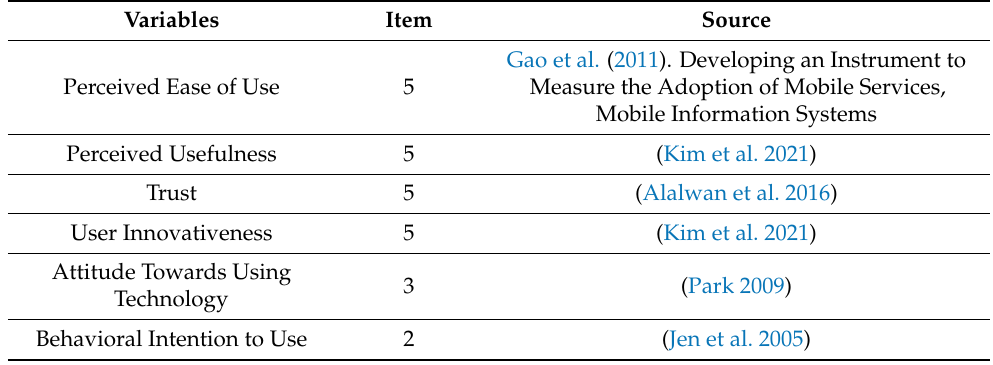
Table 1. Research